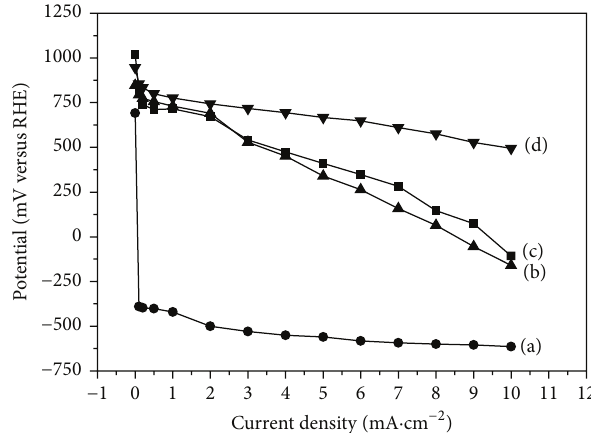
Figure 2: Working electrode potential versus current density for the optimized electrodes: ◼ (a) DGCPV; e (b) LSNV. Electrolyte— 1g ⋅ L −1 sulfide ions; 18g ⋅ L −1 NaCl; 1M NaOH; 𝑡 ∘ = 25 ∘ C.